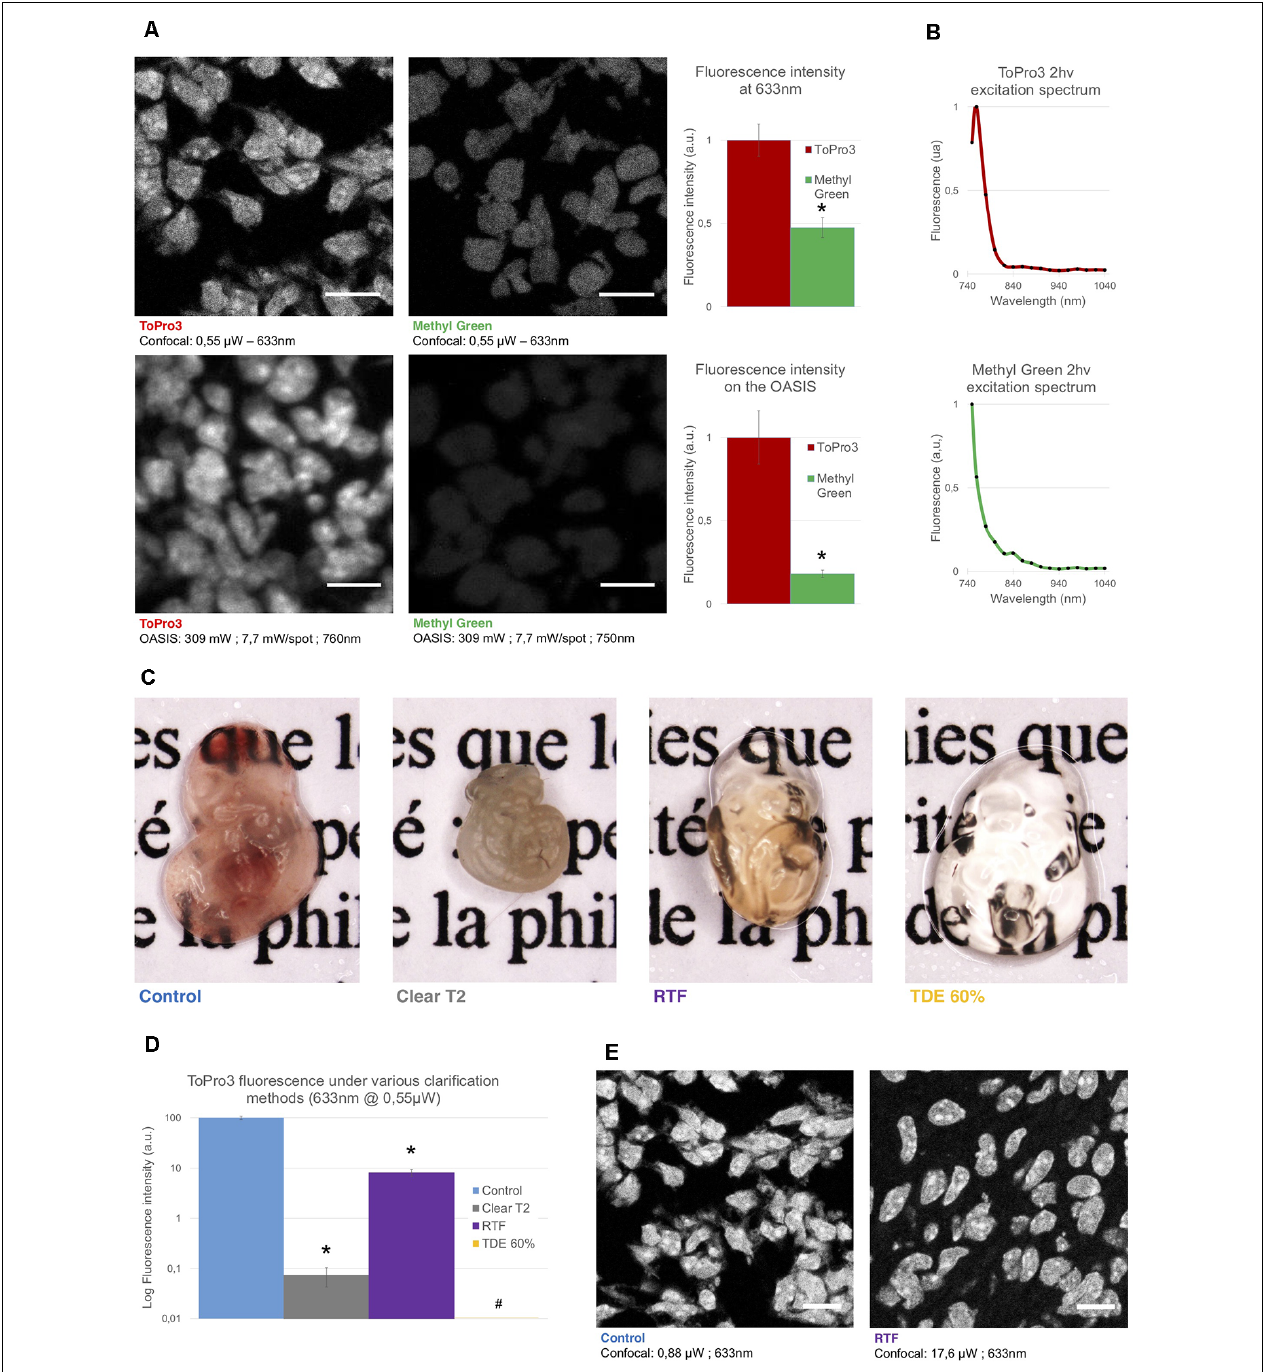
FIGURE 2 | Comparison of the used nuclear stains and clearing methods. (A) Left , optical section of a slice from an E14.5 embryo, labeled with TO-PRO3 or Methyl Green (MG) and observed on a single-spot confocal laser scanning microscope confocal laser-scanning microscope (CLSM, top ) or on the OASIS microscope ( bottom ). Scale-bar, 10 µ m. Right , relative fluorescence intensity of TO-PRO3 and MG in nuclei of E14.5 embryo slices measured on a CLSM ( top right ) or on the OASIS ( bottom right ). (B) TO-PRO3 ( top ) and MG ( bottom ) 2P-excitation spectra. Color code as in (A) . (C) Macro-photographies of E10.5 embryos in control (PBS) and following three clearing protocols [Clear T2 , rapid partial transparisation with triethanolamine formamide (RTF) and TDE 60%]. Note the variable degree of transparisation and the volume change. (D) Relative fluorescence of TO-PRO3-positive nuclei in E14.5 embryo slices observed on a CLSM after the same clearing protocols as above. Note the log-scale ∗ P < 0.0001, # Quantification impossible as the signal is too low. (E) Fluorescence loss upon clearing requires high laser powers. Confocal micrographs of slices from an E14.5 embryo labeled with TO-PRO3 under control ( left ) and after RTF clearing ( right ) along with the laser powers required to attain the same signal-to-background ratio. Scale-bar, 10 µ